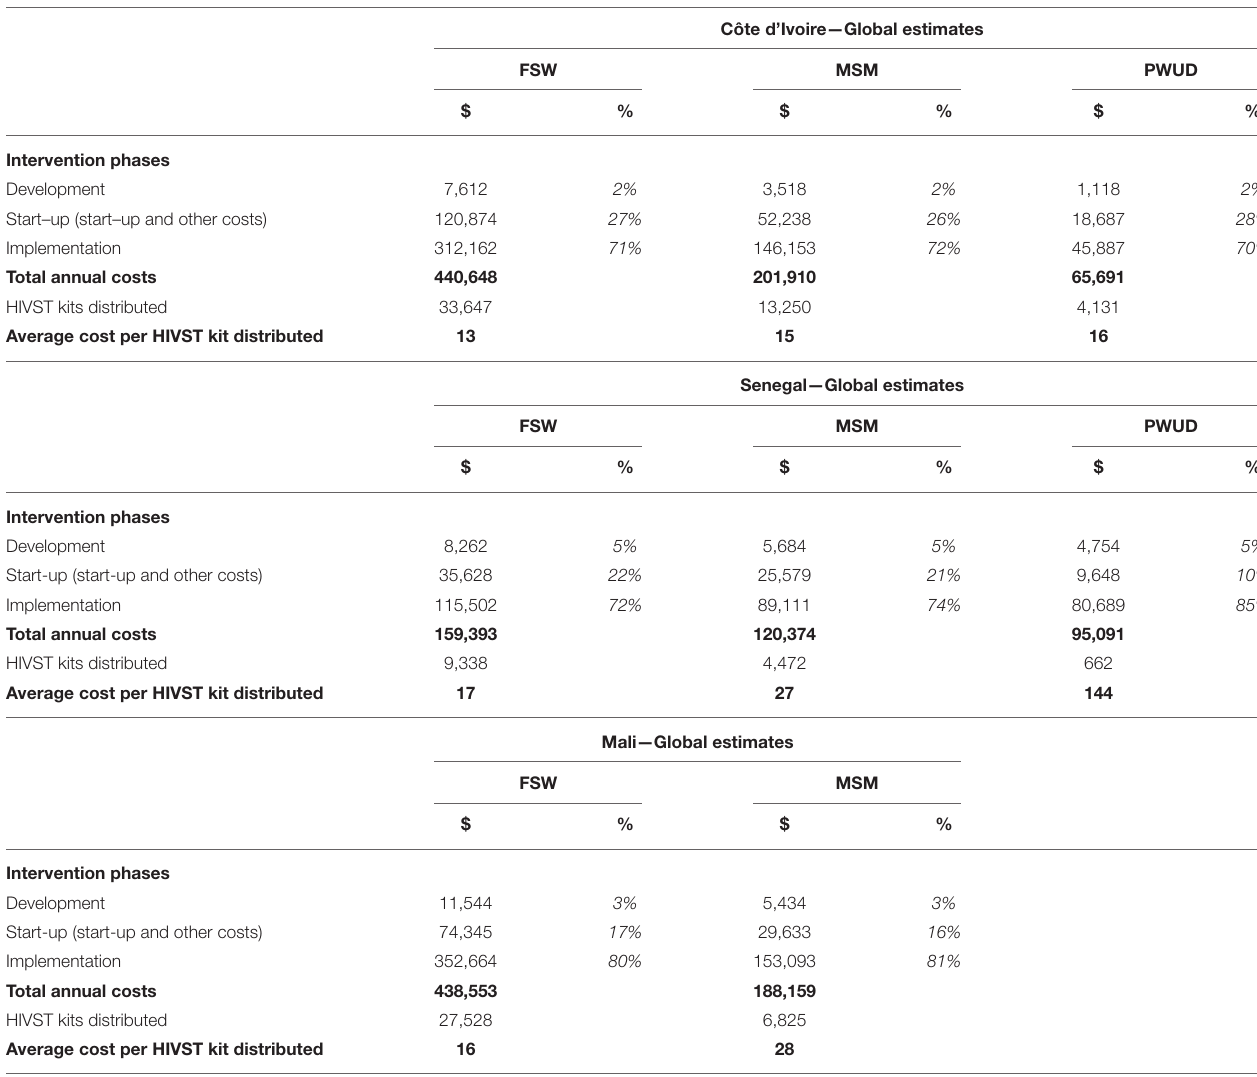
TABLE 4 | Observed total and average intervention costs by intervention phase and key group—Côte d’Ivoire, Senegal, and Mali.